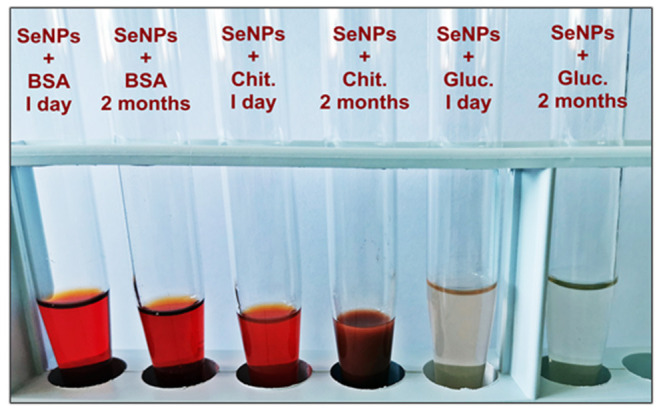
Macroscopic observation of SeNPs stability.